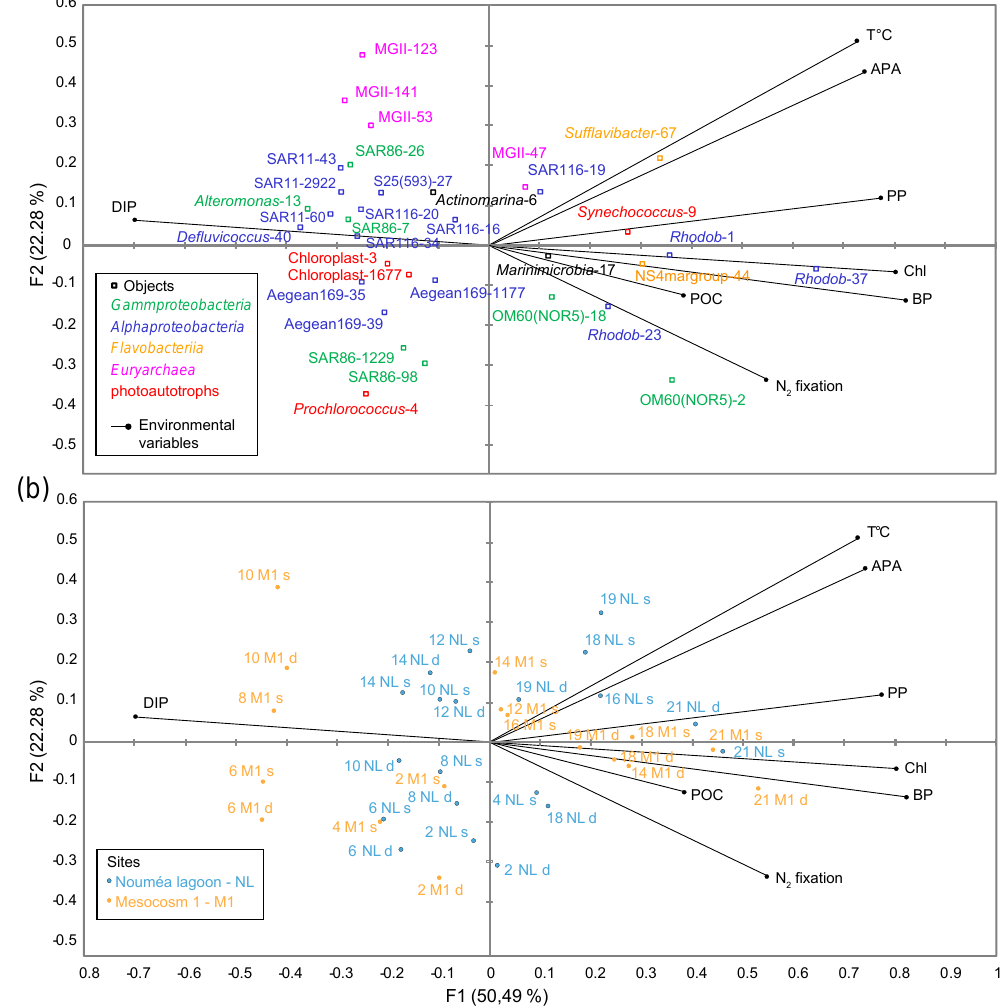
Figure 6. Canonical correspondence analysis (CCA) biplot of bacterial 16S-community structure. Correlations between environmental vari- ables and the first two CCA axes are represented by the lengths and angles of the arrows. The position of OTUs or samples relative to arrows indicates the extent to which the distribution of that OTU or the community composition of that sample is influenced by the environmental parameter represented by that arrow. (a) Ordination of OTUs constrained by the given environmental variables (black lines). Color-coded pen squares mark the 34 most abundant OTUs in the two-dimensional space of the plot. These were one Synechococcus , one Prochlorococcus , and two chloroplast OTUs (photoautotrophs, red); three SAR11, four SAR116, three Aegean169 marine group, three not further classified Rhodobacteraceae (Rhodob), one Rickettsiales S25(593), and one Rhodospirillaceae ( Defluviicoccus ) OTU (Alphaproteobacteria, blue); four SAR86, two OM60(NOR5) clade ( Alteromonadaceae) , and one Alteromonas OTU (Gammaproteobacteria, green); one Sufflavibacter and one NS4 marine group OTU ( Flavobacteriia , orange); four Marine Group II archaea (MGII, Euryarchaeota, pink); one Candidatus Actinomarina OTU ( Acidimicrobiales , black) and one unclassified Marinimicrobia OTU (black). (b) Ordination of sampling sites in the same two-dimensional space. Sites are coded “M1” and “NL” for their origin from mesocosm M1 and the Nouméa lagoon, then “ s ” or “ d ” according to the depth sampled (surface 1m and deep 12m, respectively). These codes are prefixed by a number giving day of sampling (from days 2 to